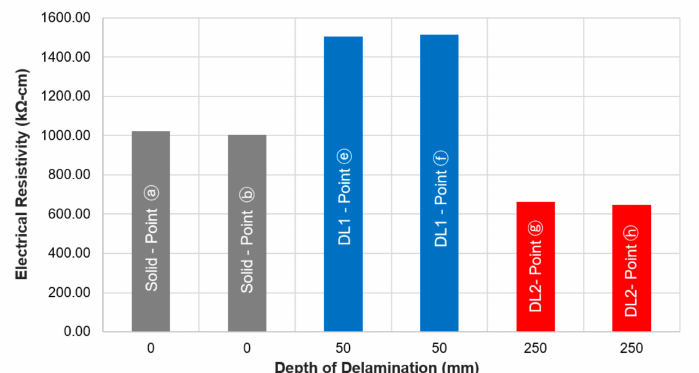
Figure 7. Average electrical resistivity values of concrete measured at the surface of the concrete slab specimen 1 over solid concrete and shallow and deep delamination defects, with probe configuration